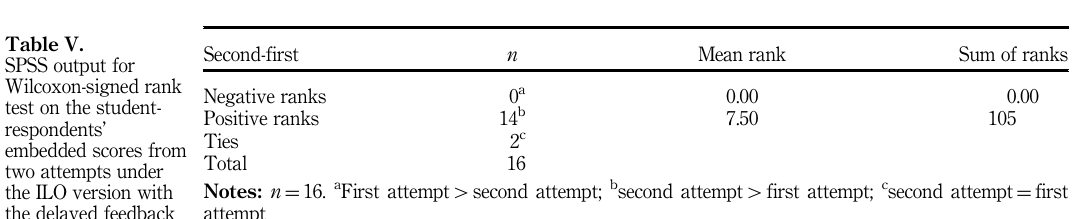
Table IV. SPSS output for Wilcoxon-signed rank test on the student- respondents ’ embedded quiz scores from two attempts under the ILO version with the immediate feedback